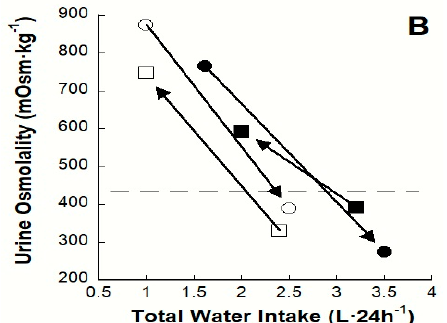
Figure 3. Relationships of total water intake to urine volume (panel A ) and urine osmolality (panel B ), when low volume drinkers (LOW, n = 14–30 each symbol) and high volume drinkers (HIGH, n = 14–22) reversed their habitual 24-h TWI during two investigations. Open symbols represent study 1 [20] and closed symbols represent study 2 [21]. Arrows denote changes from baseline (pre-intervention) to day 3 or 4 of each modified TWI. The horizontal dashed line in Panel A and Panel B represent the urine values that exist when plasma AVP is 2.0 pg · mL − 1 . Experimental design details appear in the footnotes of Tables 1 and 2.